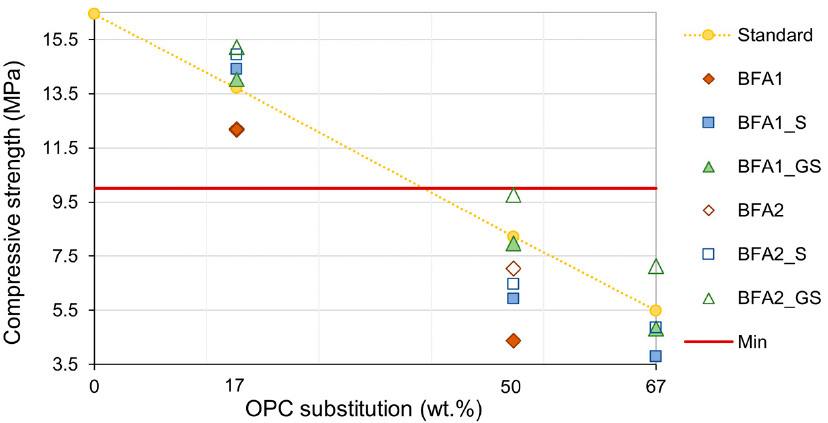
Figure 9. Effect of OPC content decrease on the compressive strength of screed mortars (cured for 28 days). Estimations assuming the strength declining simply based on the OPC amount decrease on the standard formulation are also represented (yellow circles and dotted line). The red line represents the minimum values required for the target application.